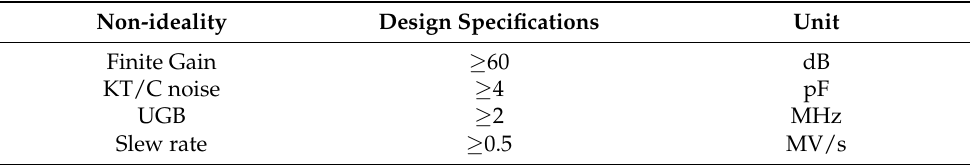
Table 1. The conditions of non-ideal circuit parameters to obtain required SNDR. Non-ideality Design Specifications